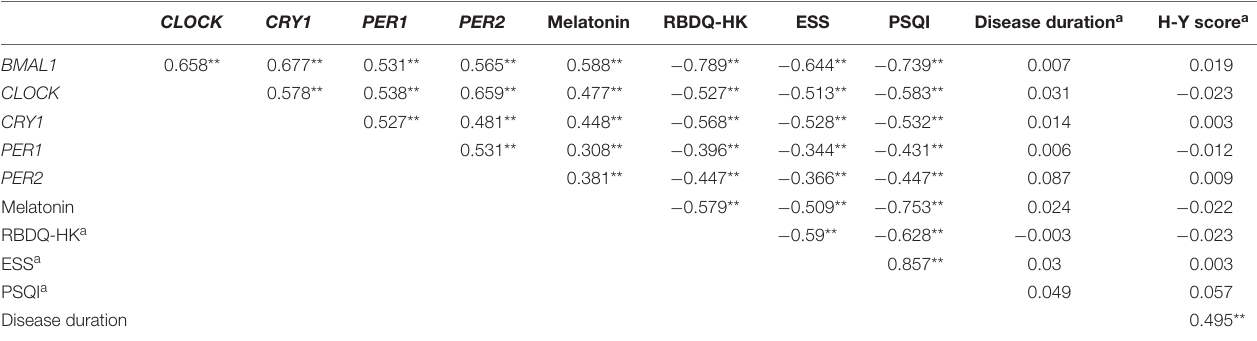
TABLE 3 | The correlation coefficients between the expression levels of clock genes in the PBMCs, sleep, and disease characteristics of the PD patients. CLOCK CRY1 PER1 PER2 Melatonin RBDQ-HK ESS PSQI Disease duration a H-Y score